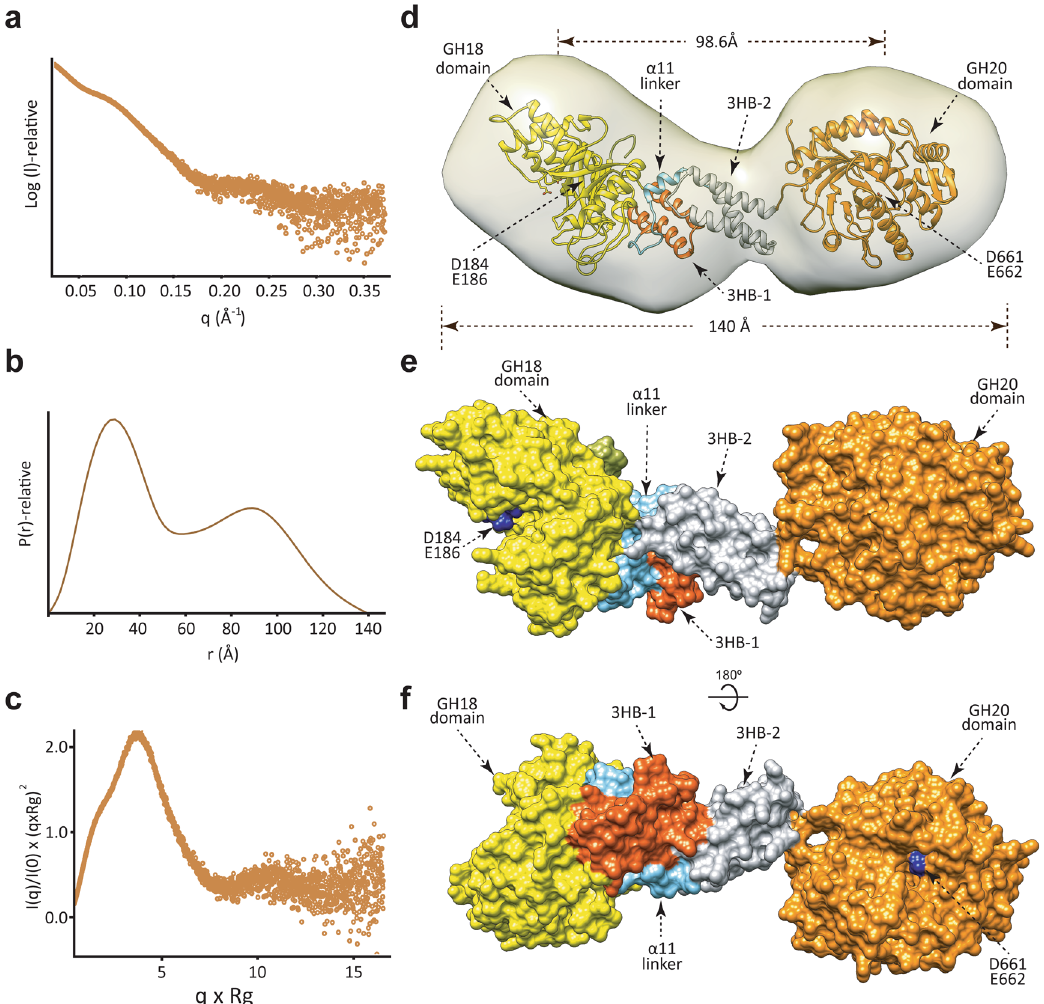
Fig. 4 The overall structure of the full-length EndoE. a SAXS scattering curve of full-length EndoE. b P(r) functions distributions of full-length EndoE. c Normalized Kratky plot of full-length EndoE. d Ab initio SAXS envelope of full-length EndoE using GASBOR. Superposition of the model of full-length EndoE. The GH18, linker, and GH20 domains are colored in yellow, green, and orange, respectively. e , f Two views of the surface representation of EndoE, showing the architecture of the GH18 (yellow), 3HB-1 (dark orange), 3HB-2 (gray), and GH20 (light orange)